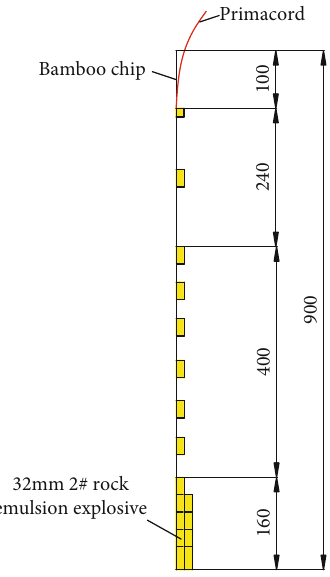
Figure 2: The charge structure of blast hole (unit: cm).